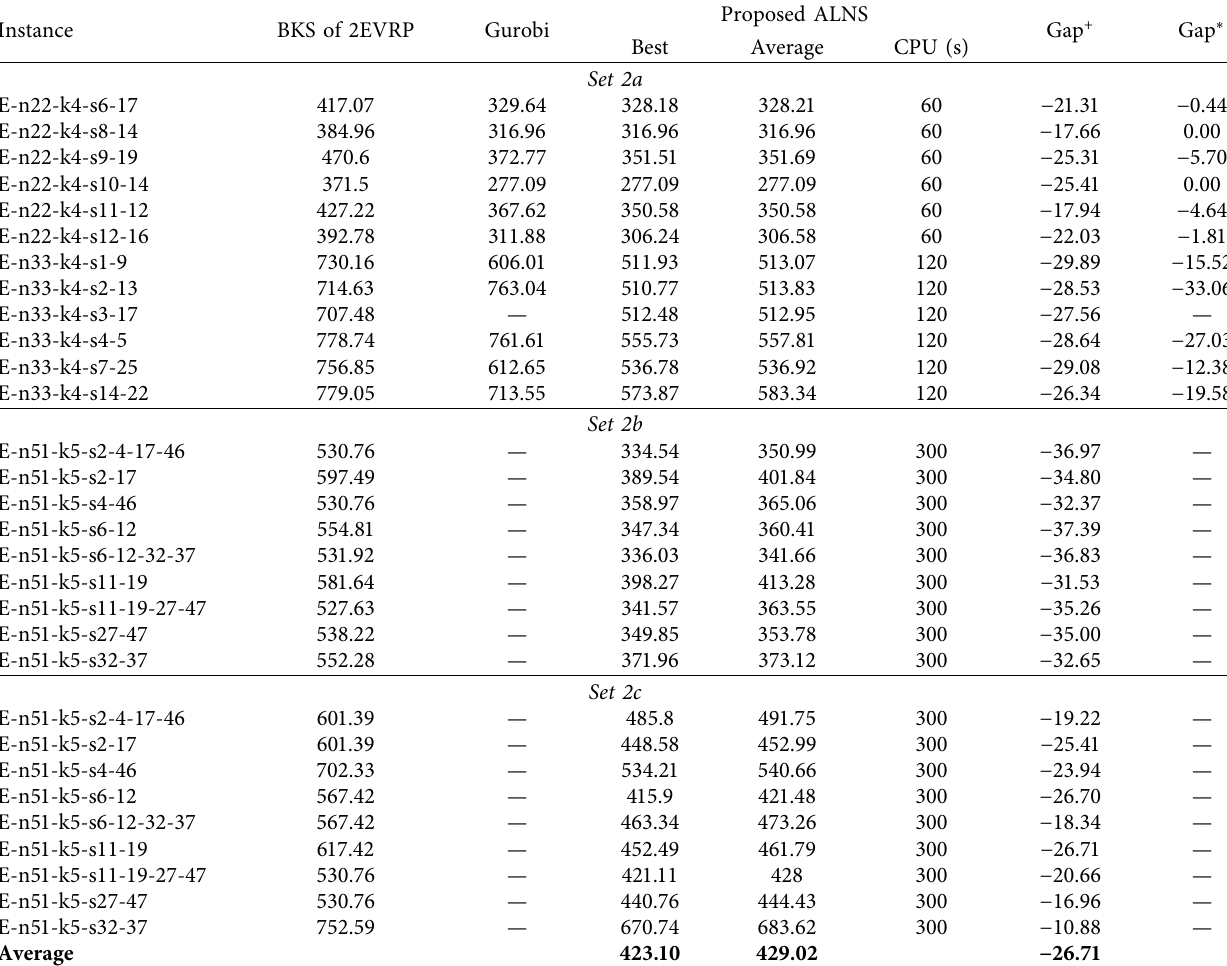
Table 8: Comparison between Gurobi and the proposed ALNS for solving Set 2 instances of 2EVRP-TN-OD. Instance BKS of